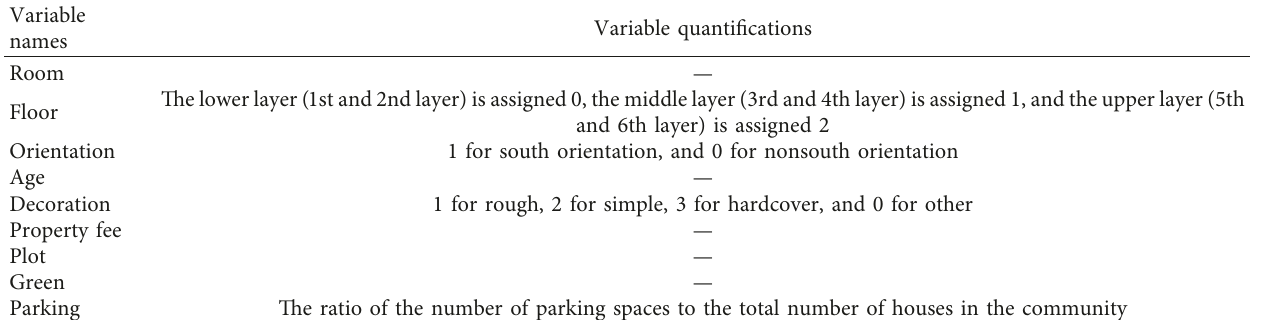
Table 2: The microdimensional control variables and their quantification.